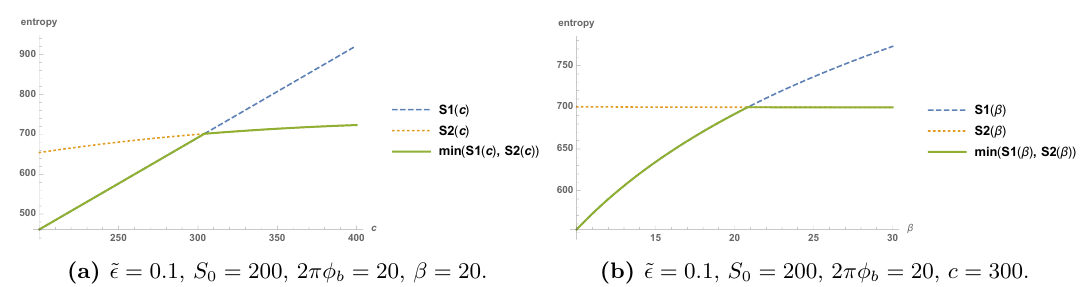
Figure 9. A numerical plot for the entropy as a function of central charge c and proper length (cid:12) : S 1 is the e(cid:11)ective entropy without island and S 2 is the e(cid:11)ective entropy with island contribution. The von Neumann entropy is the minimum of these two